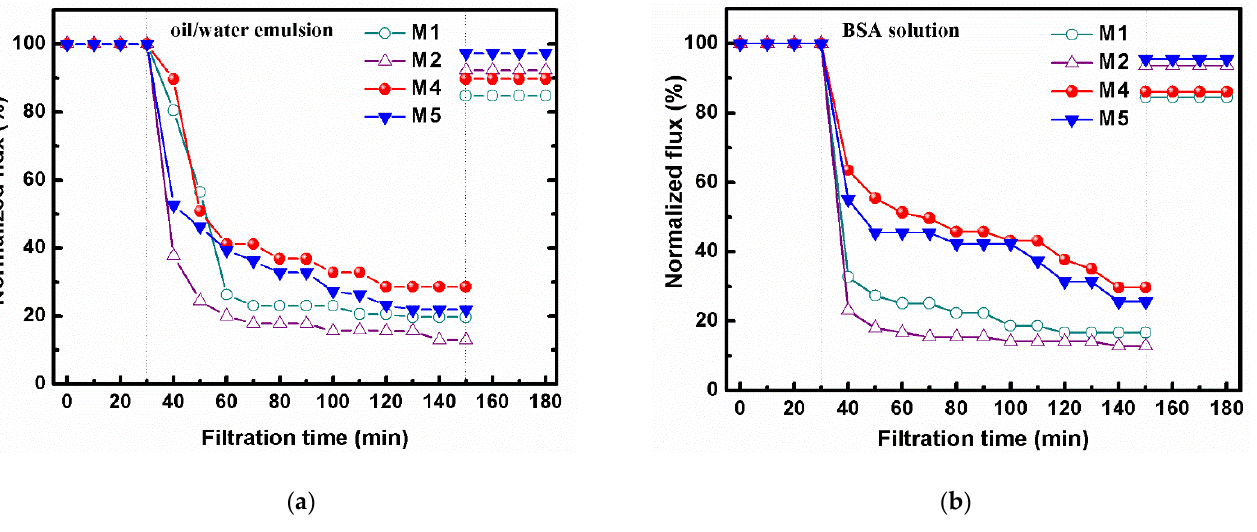
Figure 5. The normalized flux during the filtration of: (a) oil/water emulsions (0.1 g L − 1 , pH 7) and (b) BSA solutions (1.0 g L − 1 , pH 3.6). Table 2. Parameters in the filtration of oil/water emulsions.